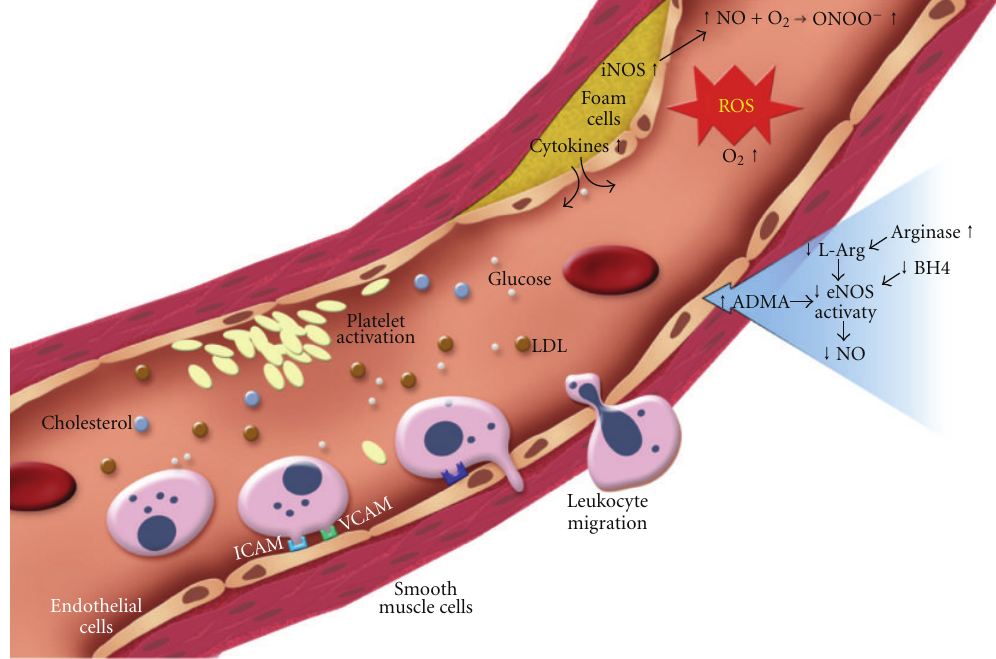
Figure 2: Hyperglycemic e ff ects on the blood vessel. Atherosclerotic plaque formation initiated through uptake of LDL from blood by endothelial cells. Foam cells produce proinflammatory cytokines that are released into the lumen of blood vessel (far right). Increased ROS production through iNOS leads to increased ROS generation. Steps involved in leukocyte adhesion and migration (bottom left). Increased glucose leads to decreased L-arginine and BH4, which leads to decreased NO production in endothelial cells. All of these factors are proinflammatory and